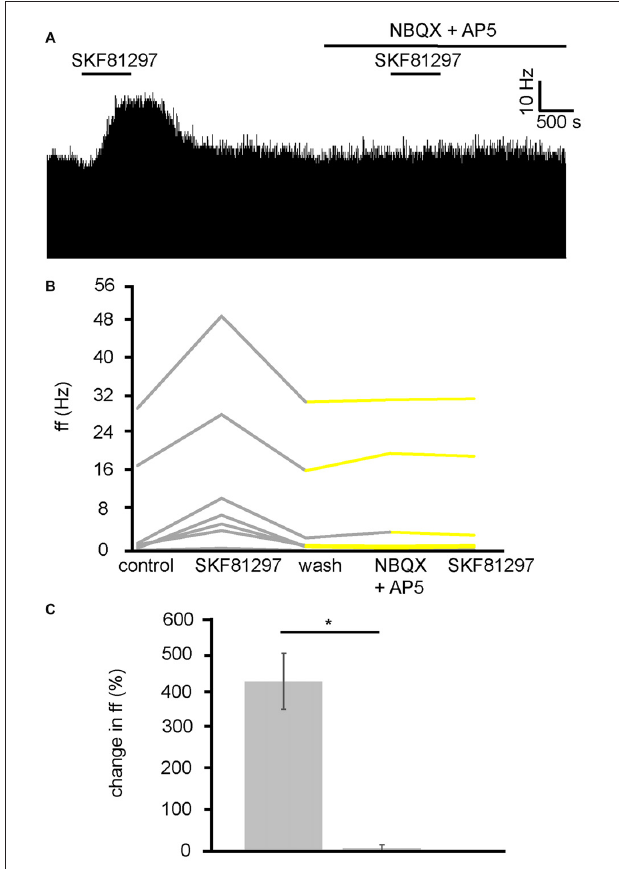
FIGURE 7 | D1-like receptor mediated excitation requires ionotropic glutamate receptors. (A) Excitatory responses to SKF81297 application alone that are no longer present in response to SKF81297 in the presence of NBQX and AP5. (B) Firing frequency for (ff) seven VP neurons in response to SKF81297 application and SKF81297 application in the presence of NBQX and AP5, similar to that illustrated in panel (A) . Firing frequency was measured before the application of SKF81297, during the application of SKF81297, after a period of wash out, in response to the application of NBQX and AP5 and finally in response to SKF81297 in the presence of NBQX and AP5. Responses characterized by significant ( P < 0.05) changes in firing frequency are in gray, the other ones in yellow. (C) Significant differences in firing frequency (ff) to SKF81297 alone compared to the application of SKF81297 in the presence of NBQX and